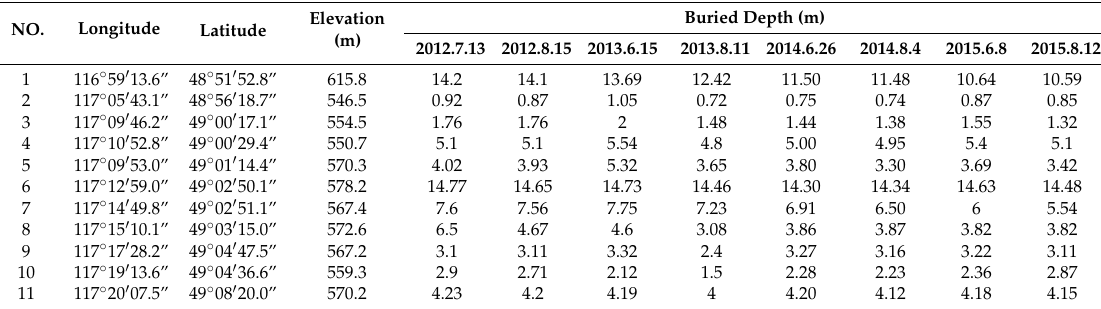
Table 2. Groundwater levels around Lake Hulun (2012 to